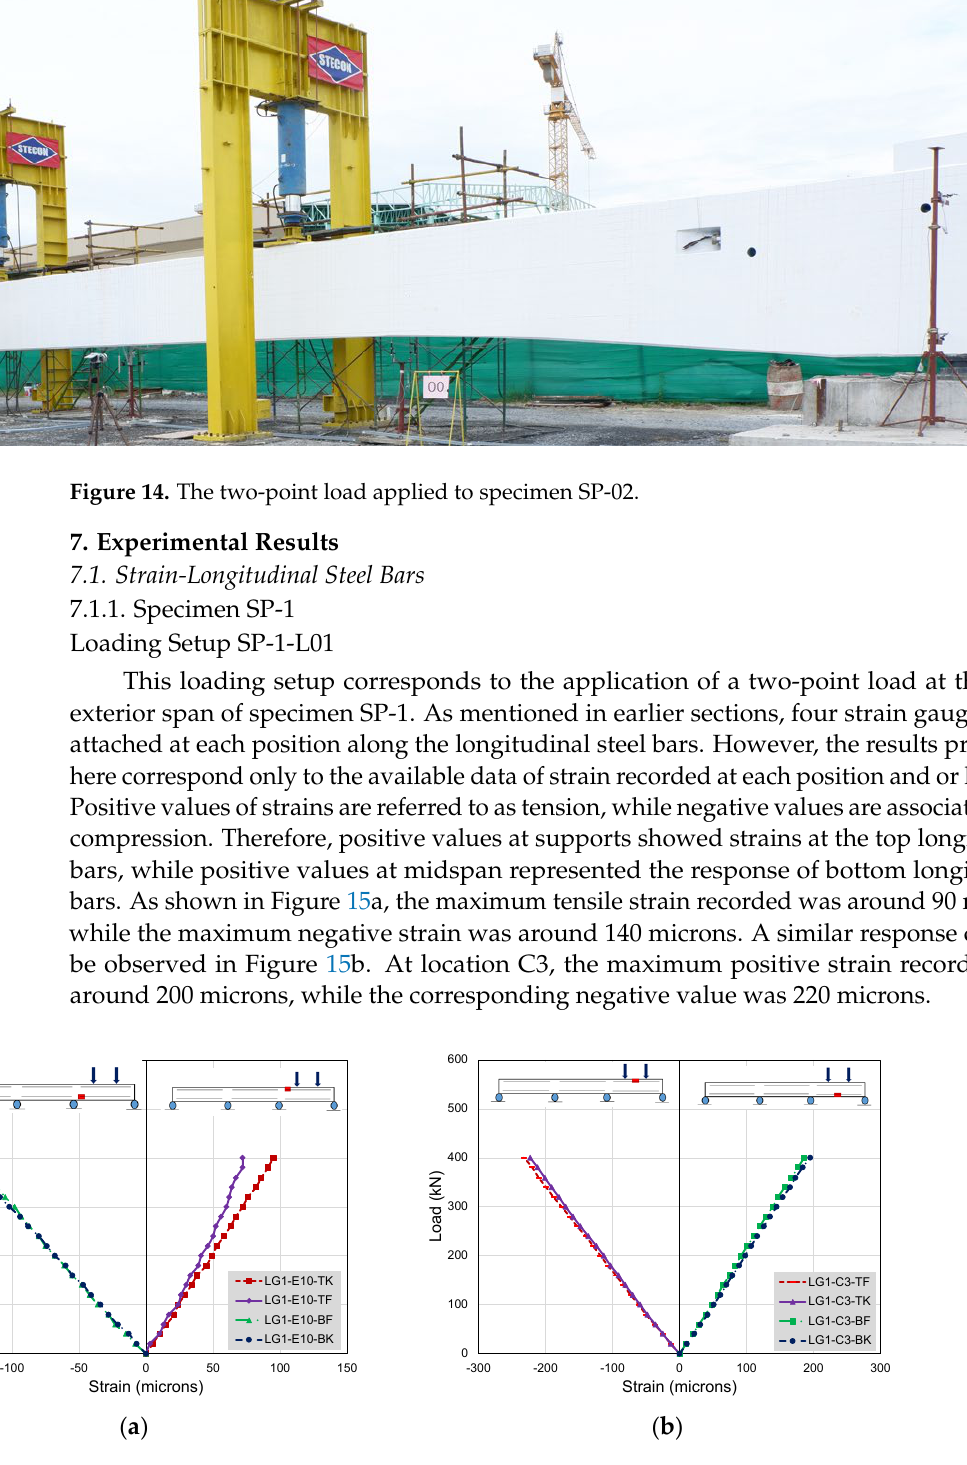
Figure 15. Strain versus load responses ( a ) location E10 and ( b ) location C3.